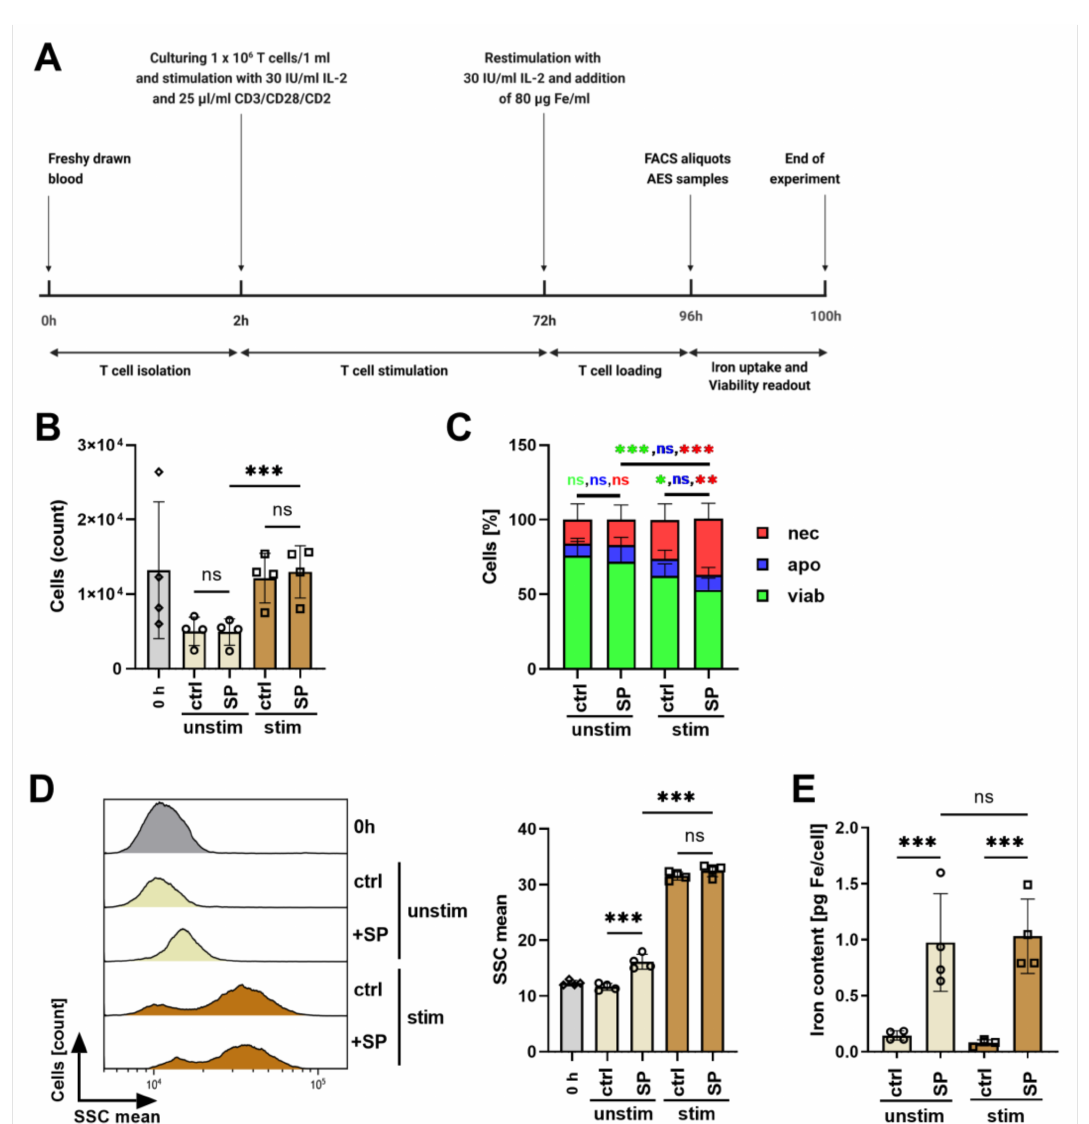
Figure 3. Influence of T cell stimulation on nanoparticle uptake. ( A ) Experimental setup. 1 × 10 6 CD3+ T cells in 1 mL T cell medium were stimulated for 72 h and then re-stimulated and incubated with 80 µ g/mL SPIONs for 24 h. Unstimulated and/or cells without SPIONs served as controls. Subsequently, cells were analyzed by flow cytometry and atomic emission spectroscopy (AES). Determination of cell count ( B ) and viability ( C ) in flow cytometry. AxV-FITC-/PI- cells were considered viable, AxV-FITC+/PI- cells apoptotic, and PI+ cells necrotic. ( D ) Side Scatter (SSC) increase of AxV-FITC-/PI- cells indicates nanoparticle uptake. E) Determination of the iron amount (pg/cell) by AES. ( B – E ) Experiments were performed in triplicates of T cells from four donors. Shown are the mean values with standard deviations. Significance was estimated by a 2-way ANOVA with a Tukey post hoc test; * p ≤ 0.05; ** p ≤ 0.01; *** p ≤ 0.001. ctrl: control; ns: not significant; SP: SPIONs, stim: stimulated; unstim: unstimulated; nec: necrotic; apo: apoptotic; viab: